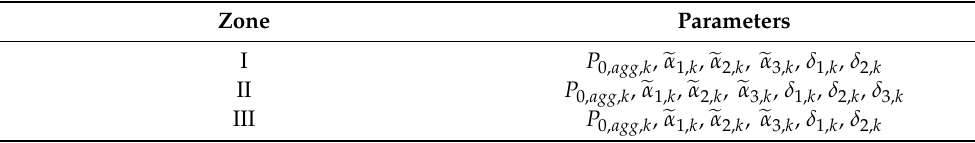
Table 3. Parameters to be identified in each